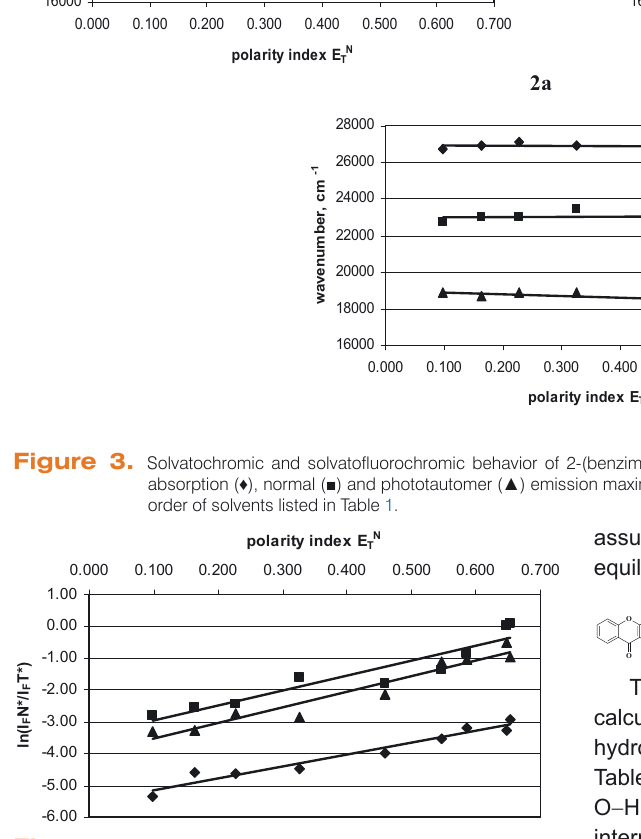
Figure 4. Natural logarithm of the normal-to-phototautomer fluores - cence intensity ratio ln (I